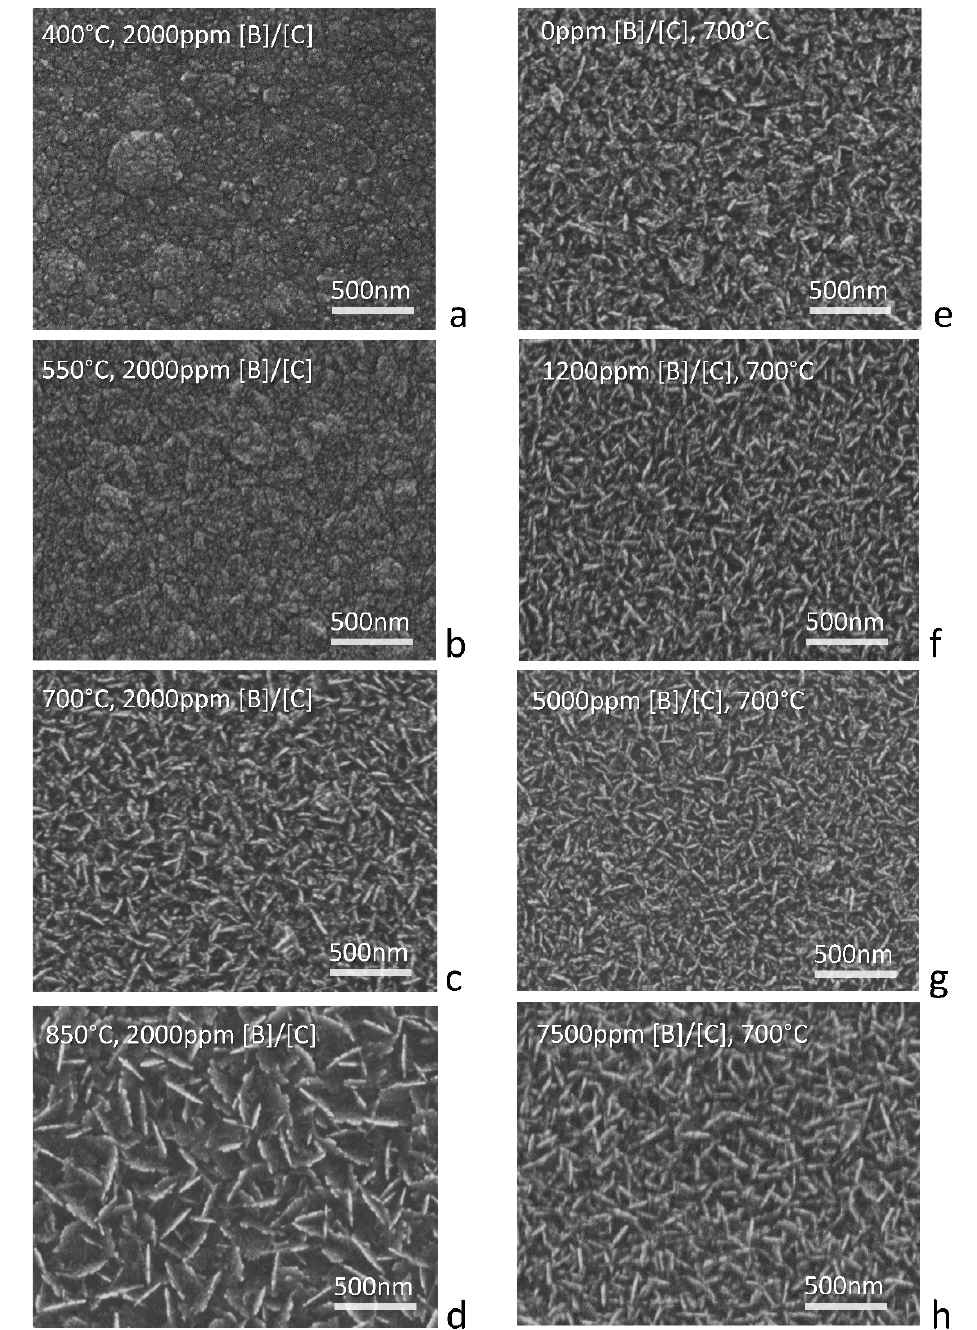
Figure 2. Scanning electron microscopy (SEM) picture of B-CNW growth, respectively, at ( a ) 400 ◦ C, ( b ) 550 ◦ C, ( c ) 700 ◦ C, and ( d ) 850 ◦ C at 2000 ppm [B]/[C] ratio and with ( e ) 0, ( f ) 1200, ( g ) 5000, and ( h ) 7500 ppm [B]/[C] at 700 ◦ C. Sample ( c ) belongs to both series. It was found that a randomly vertically aligned wall structure belonged to the substrate only for samples with a temperature of process higher than 700 ◦ C. B-CNWs are homogeneously distributed all over the substrate and they have sharp top